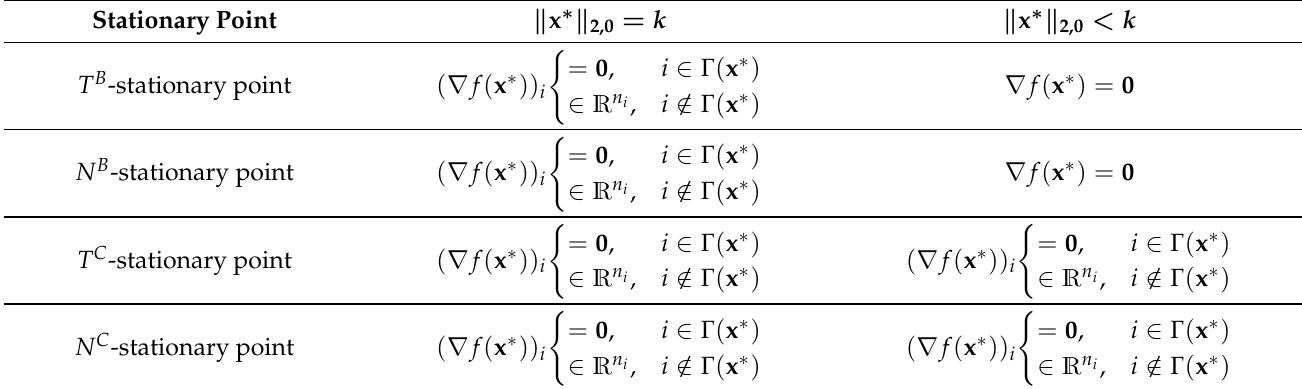
Table 1. The characterizations of T B -, N B -, T C -, N C - stationary point for Problem